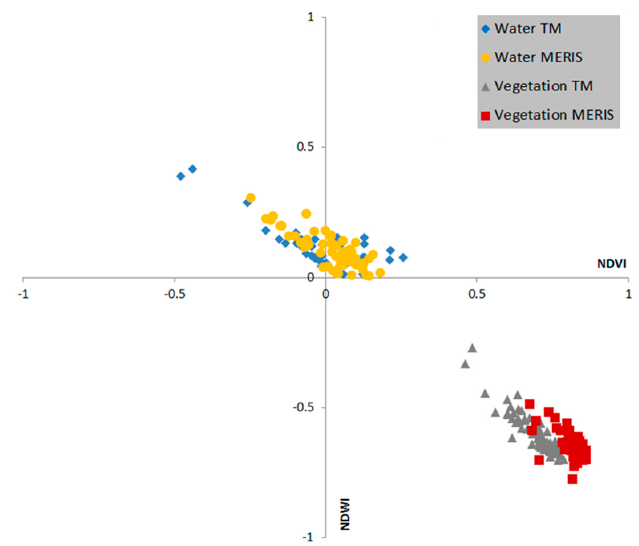
Figure 5. Scatter plot of TM versus MERIS NDVI and NDWI over water and vegetation features.